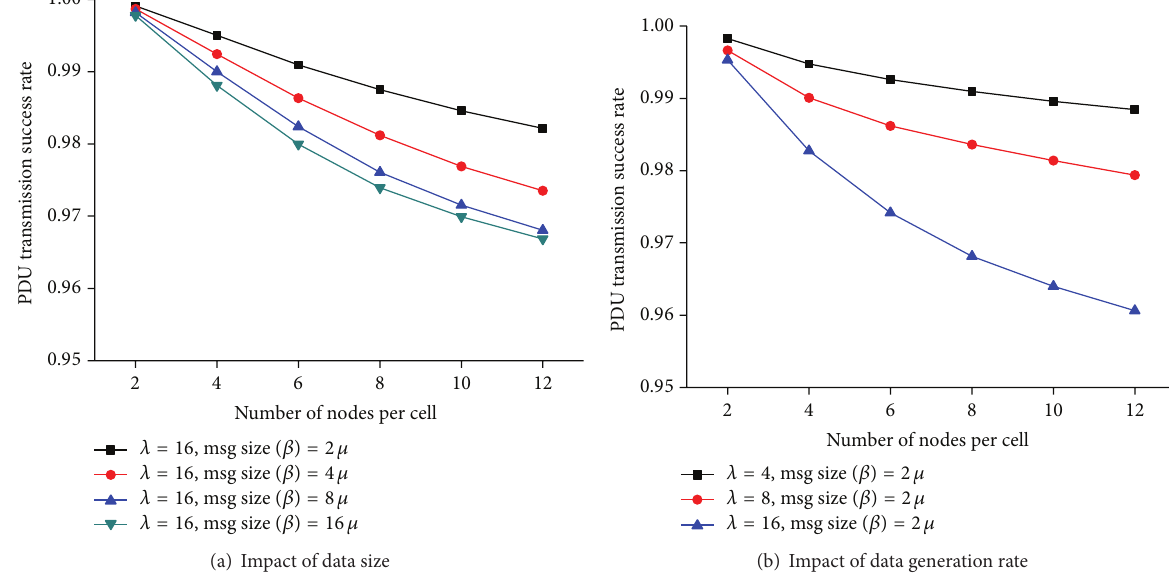
Figure 8: Data transmission success